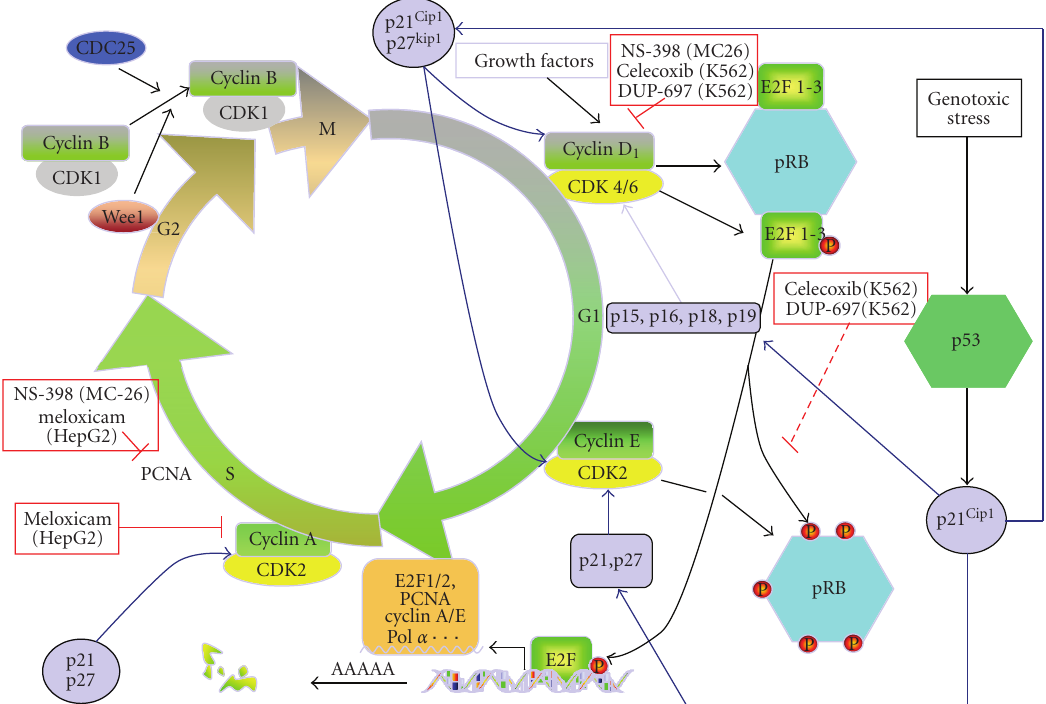
Figure 3: E ff ects of COX-2 inhibitors on cell proliferation. Cell cycle is divided into di ff erent steps: G1, S, G2, and M (mitosis). This process is regulated by cyclin proteins, which activate cyclin-dependent kinase (cdk) and phosphatase (i.e., CDC25) or kinase like cyclin-dependent kinase inhibitors such as p16, p15, p18, p19, p21, and p27 [54]. Selective COX-2 inhibitors are able to modulate some cell cycle checkpoints. In this picture, some examples of this link have been shown for di ff erent cell types: MC26, colorectal cancer; HepG2, hepatocellular carcinoma; K562, chronic myeloid leukemia. Cdk; cyclin-dependent kinase; pRb, retinoblastoma protein; PCNA, proliferating cell nuclear